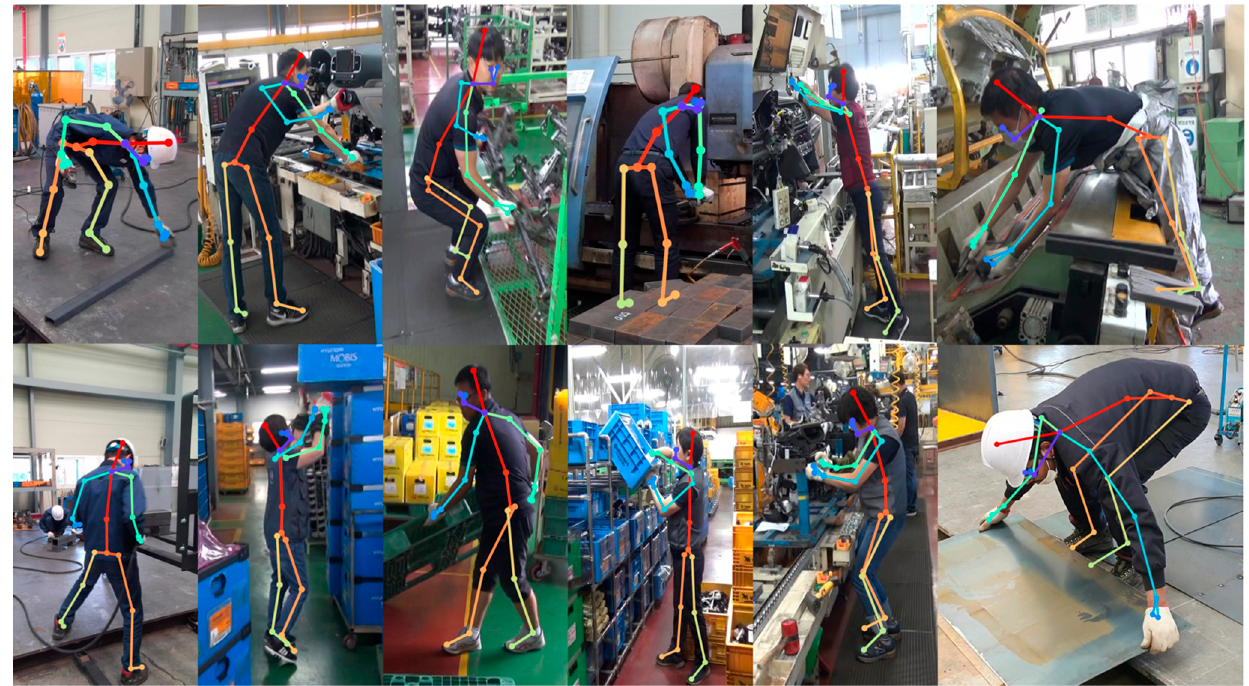
Figure 16. Image samples for RULA.